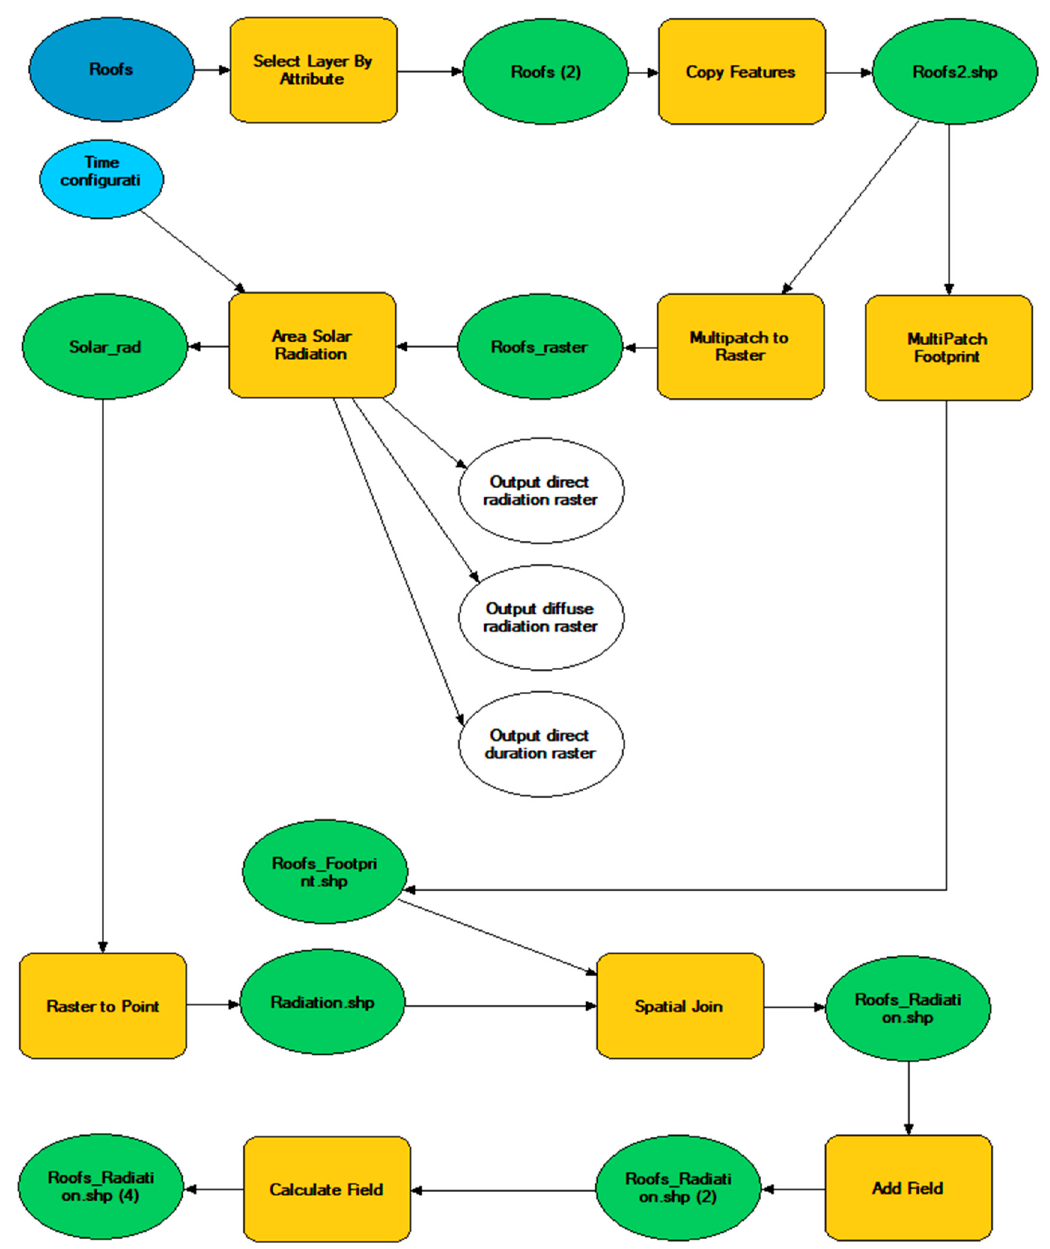
Figure 1. The SOLIS calculation workflow.